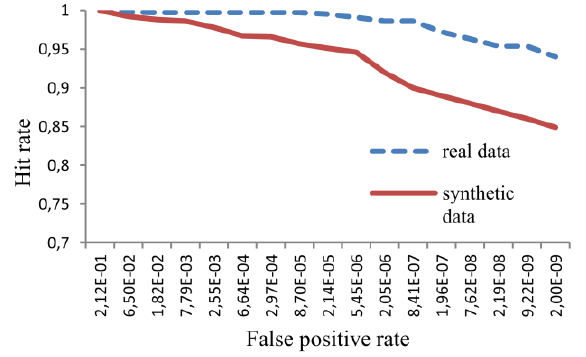
Figure 7: Comparison of detectors trained on real and synthetically generated data.